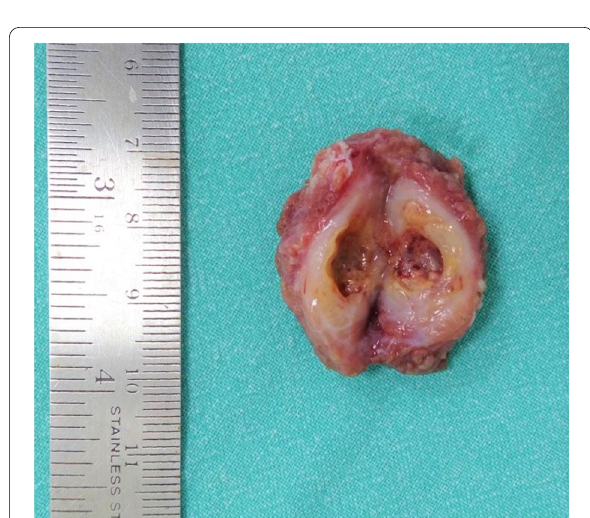
Fig. 6 Cut section of cyst with its cavity